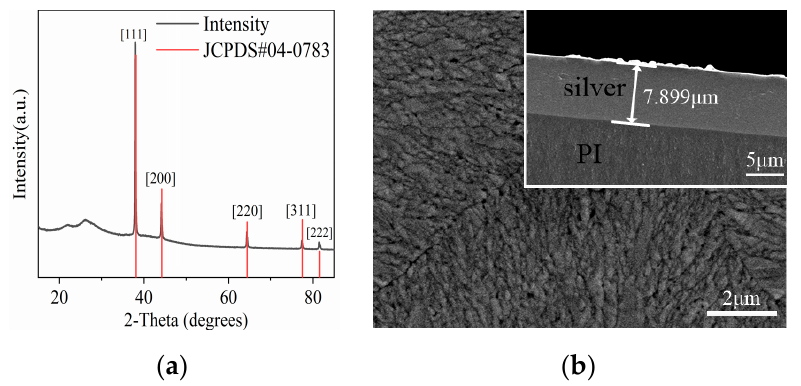
Figure 4. ( a ) XRD image. ( b ) Top and cross-sectional SEM